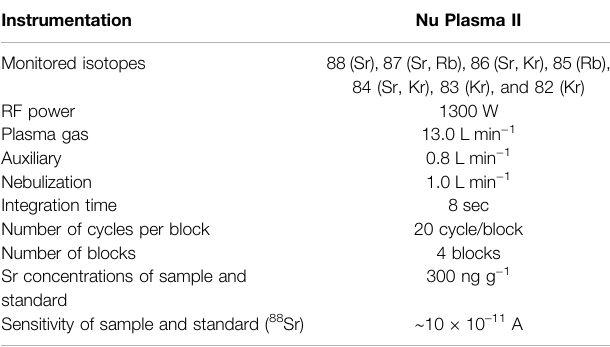
TABLE 1 | Details of the operational parameters of the MC-ICP-MS (Nu Plasma II; Nu Instruments, UK) at